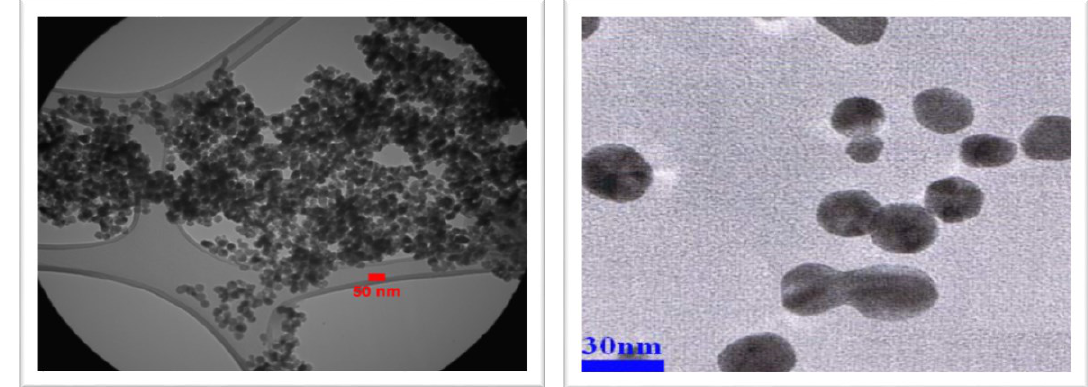
Fig. 1. Transmission electron microscopy image of